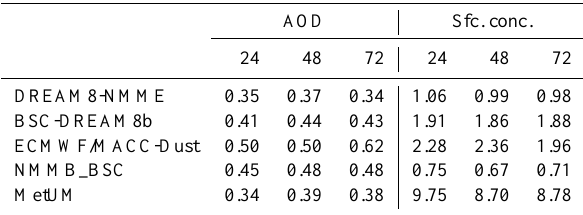
Table 6. Mean normalized gross error quantifying the performance in reproducing AERONET total AOD in southern Europe and sur- face concentration (sfc. conc.) for each model and each lead time forecast. Note that for the models, the dust AOD and dust total sur- face concentrations were used. AOD Sfc. conc. 24 48 72 24 48 72 DREAM8-NMME 0.35